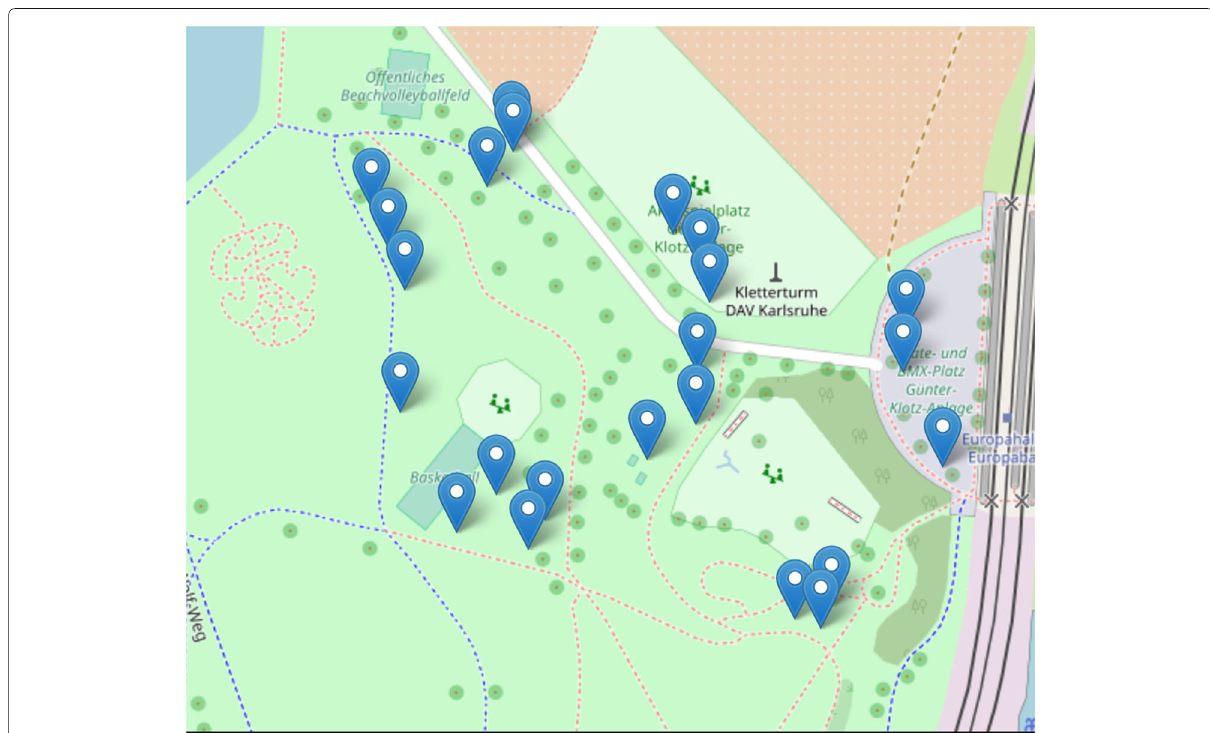
Fig. 2 Deployment of Raspberry PI access points. The blue markers indicate the positions of the access points